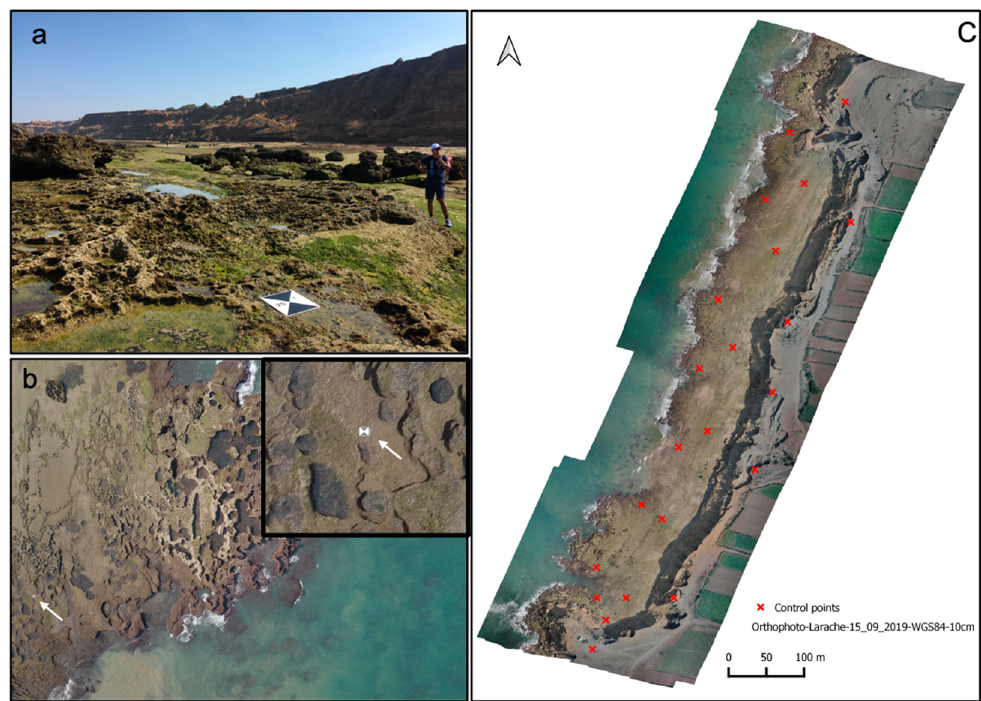
Figure 6. Ground control points (GCPs) deployed in the study area: ( a ) photograph of a GCP positioned on the rocky platform; ( b ) GCP (white arrow) visible on an image; ( c ) spatial distribution of GCPs in the study area.